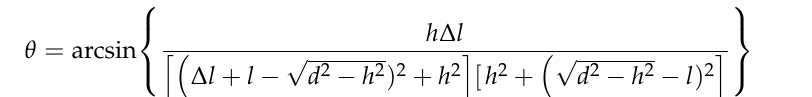
Figure 5. Hardware block diagram of the control system.